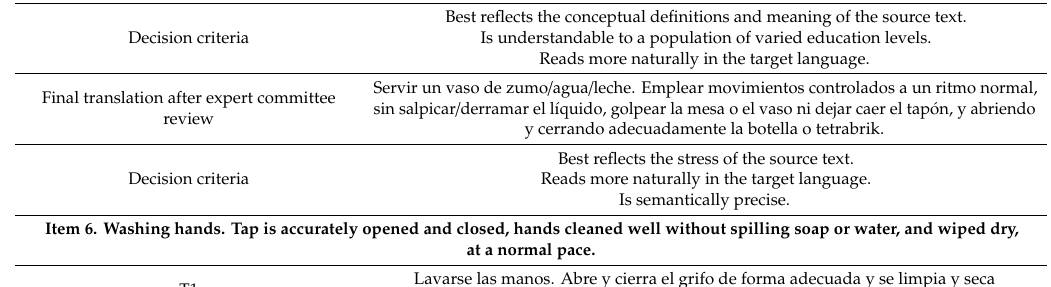
Best reflects the conceptual definitions and meaning of the source text. Reads more naturally in the target language. The syntax is correct.